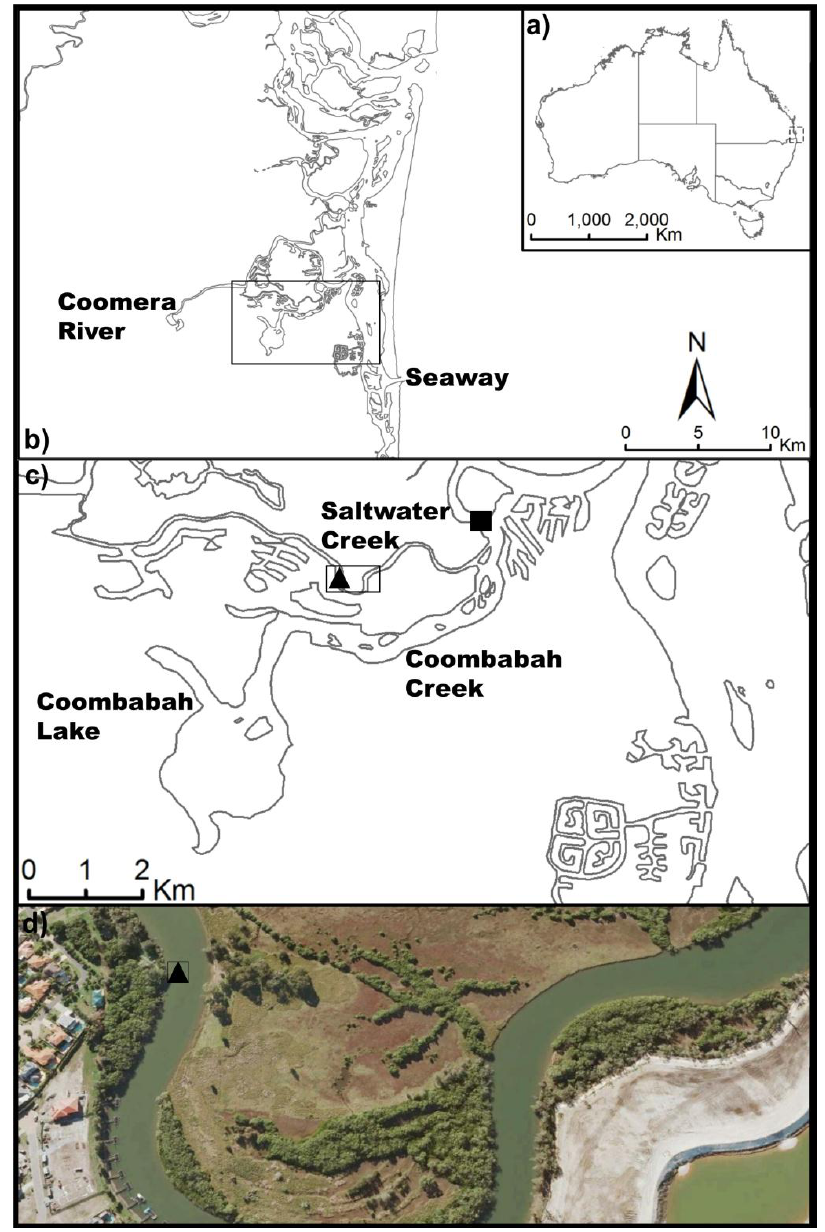
Figure 1. Map of: ( a ) Australia, showing ( b ) the Gold Coast Broadwater, and ( c , d ) the sediment sample collection site within Saltwater Creek ( ▲ ) and water collection site nearby the creek entrance ( ■ ) (satellite imagery source: Google Earth).